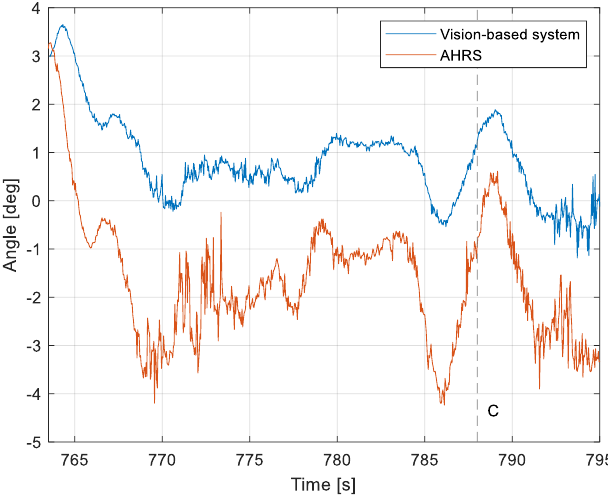
Figure 23. Angle between the longitudinal axis of the aircraft and the centerline: Flight no. 3 (marker C corresponds to the moment of recording the images in Figure 13).